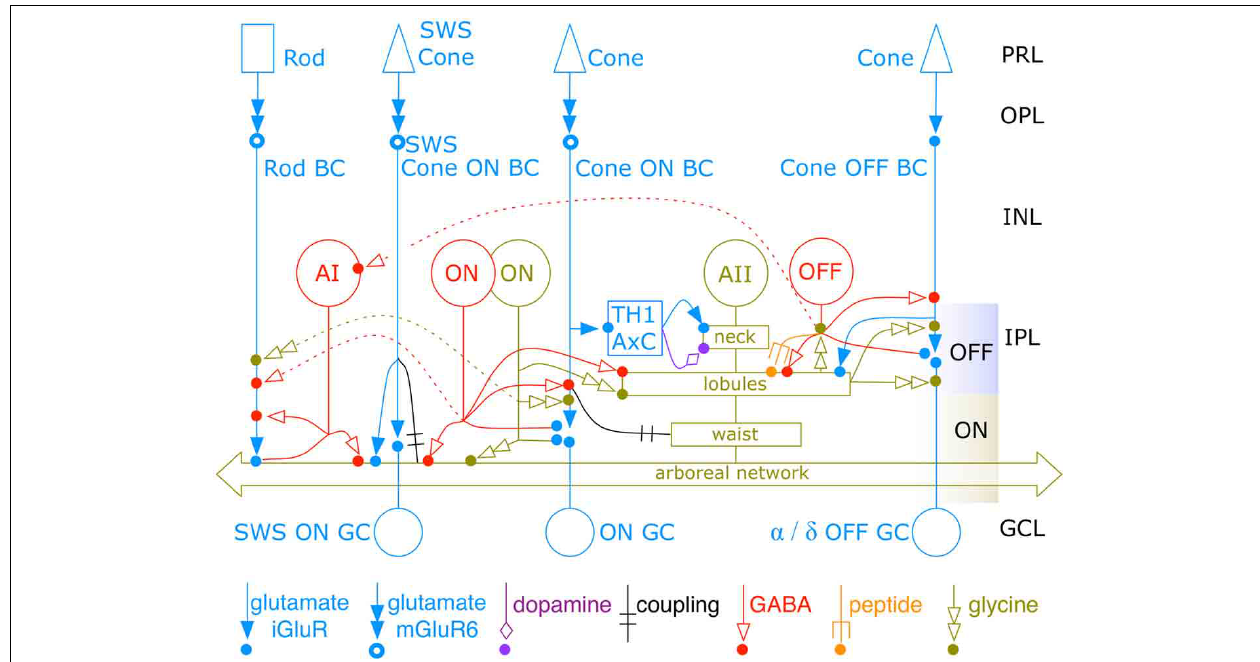
FIGURE 14 | The new AII amacrine cell network. The complete AII cell network spans 4 classes of excitatory glutamate inputs, three coupling partners, dopamine modulation, three wide-field GABAergic inputs, peptide modulation, narrow-field glycinergic input, and outputs to OFF bipolar cells, OFF inhibitory neurons and two classes of OFF ganglion cells. All classes of CBb (except CBb7) and CBa bipolar cells are lumped into single ON and OFF channels. Multiple classes of ON and OFF amacrine cells are lumped into single representative classes. Dashed lines show paths for cone → rod